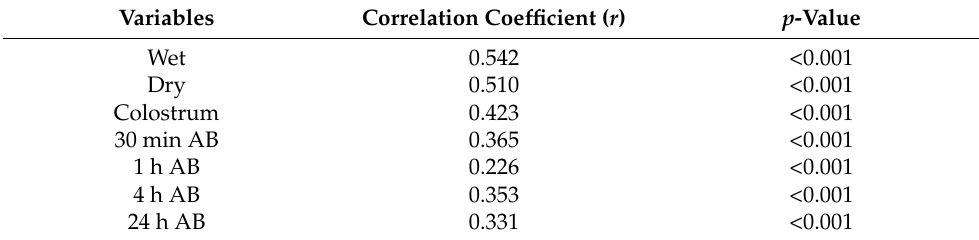
Table 10. Significant correlations between puppy’s weight and their superficial temperature at N thermal window.